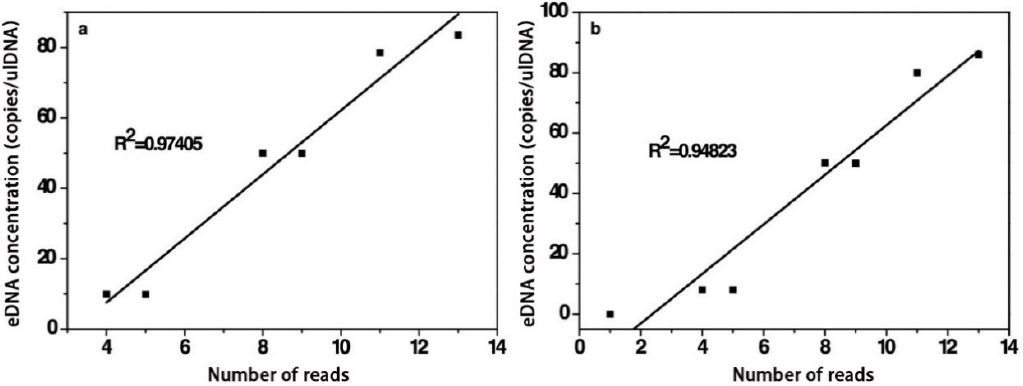
Figure 4. The correlation between detected time using cloning sequencing and DNA copies of two species: ( a ) Zacco platypus ; ( b ) Odontobutis potamophila.